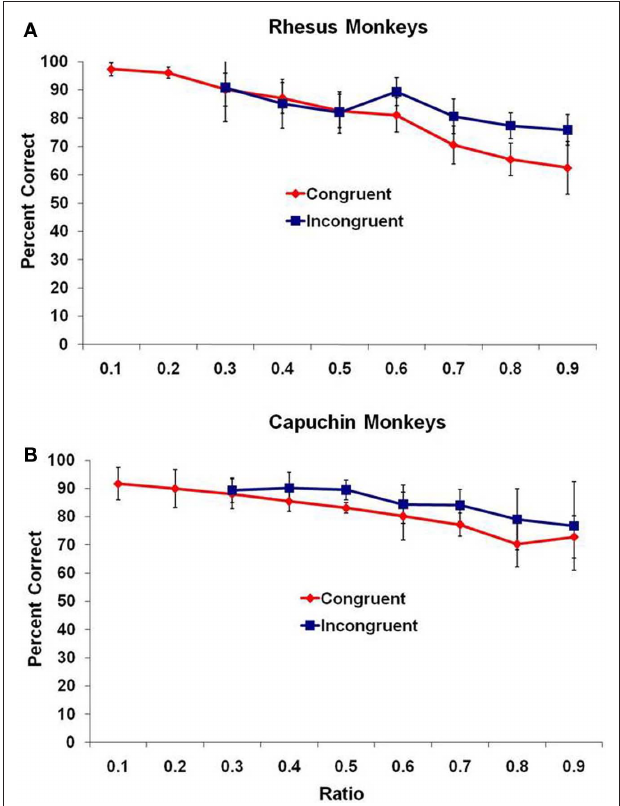
Figure 1 | Mean performance for (A) rhesus monkeys and (B) capuchin monkeys for the two trial types, presented as a function of the ratio between subsets. Bars indicate 95%